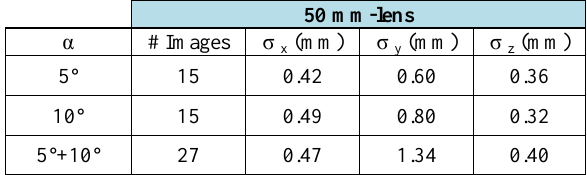
The best accuracy level (highlighted in yellow) is delivered by the dataset including images acquired by both lenses. In this case, an accuracy level below half a centimetre is achieved. The color-coded map associated with this acquisition protocol is shown in Figure 5, together with a view of the compared 3D scene. The colour scale ranges from -10 mm (blue) to 10 mm (red).